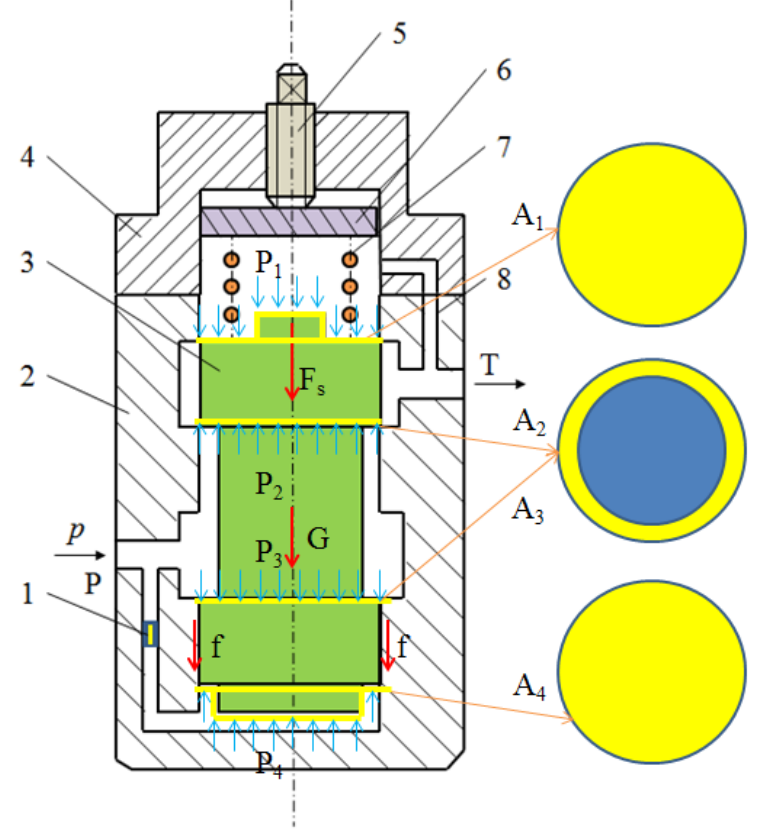
Figure 8. The structural diagram of the SVTDARVWEO.